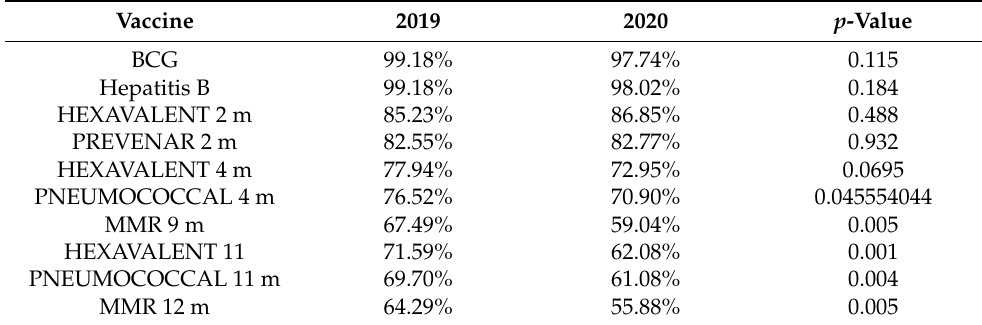
Table 3. Vaccine coverage: comparison between 2019 and 2020.